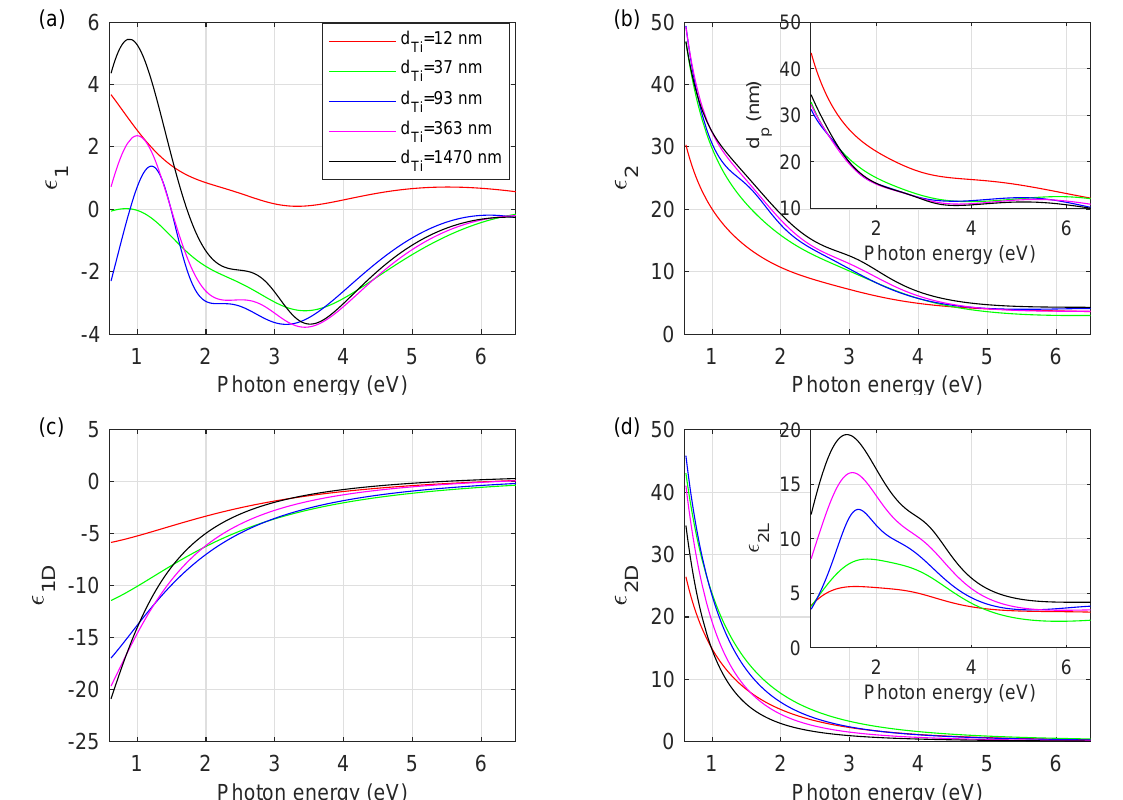
Figure 4. ( a ) The real ( ε 1 ) and ( b ) imaginary ( ε 2 ) parts of the complex dielectric function ( (cid:101) ε ) of the titanium films. Inset: the penetration depth ( d p ). ( c ) The real ( ε 1 D ) and ( d ) imaginary ( ε 2 D ) parts of the Drude contribution to (cid:101) ε . Inset: The separate contributions from the Lorentz terms ( ε 2 L ) to the imaginary part of (cid:101) ε . The complex dielectric function of the Ti films of thickness equals 12 nm and 37 nm is taken from Reference [13].